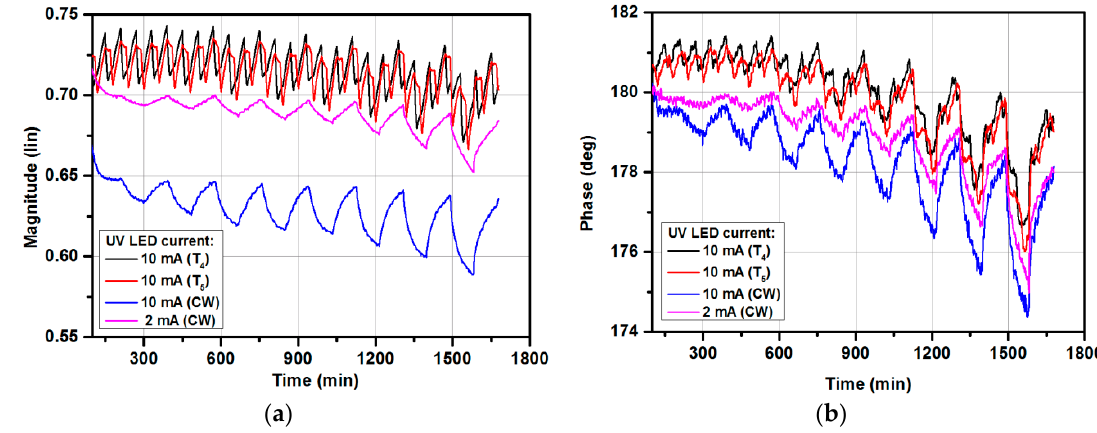
Figure 7. The gas-sensing characteristics under exposure to acetone in the 0–200 ppm range: ( a ) magnitude changes with various PWM cycles (T 4 , T 5 ); ( b ) phase changes with various PWM cycles (T 4 , T 5 ).